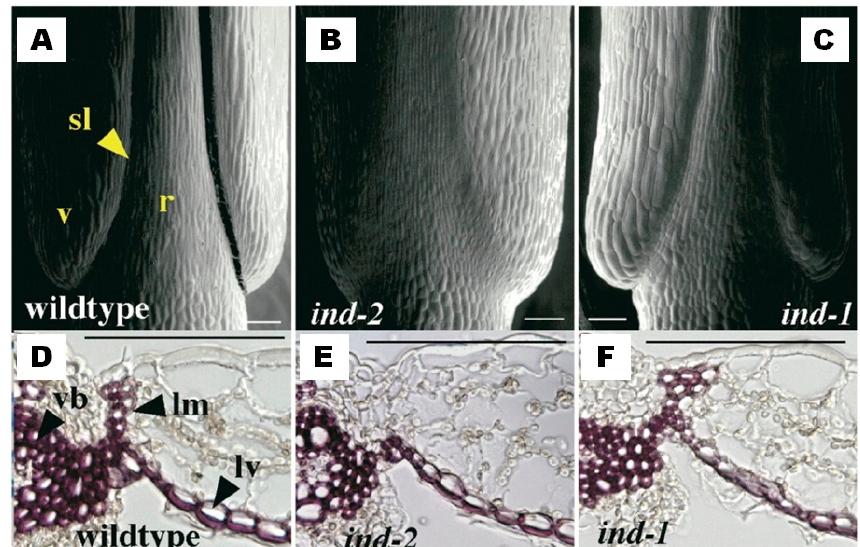
Figure 8. Role of Indehiscent in correct differentiation and lignification of the dehiscence zone. ( A – C ) Representative scanning electron microscopy of dehiscence zone in mature fruit of wild-type A. thaliana ( A ) and in two A. thaliana indehiscent mutants for ind-2 ( B ) and ind-1 ( C ). The ind-2 mutant lacks correct differentiation of valve margins. sl, separation layer; r, replum; v, valves. ( D – F ) Representative transverse sections of the mature fruit of wild-type A. thaliana ( D ) and in the two A. thaliana indehiscent mutants for ind-2 ( E ) and ind-1 ( F ), with lignin-specific staining with phloroglucinol. The ind-2 mutant lacks lignification of the valve margin cells. vb, vascular bundles; lm, lignified valve margin layer; lv, inner lignified valve cell layer. All scale bars represent 100 µ m (reproduced with permission from Liljegren et al. [8]; with